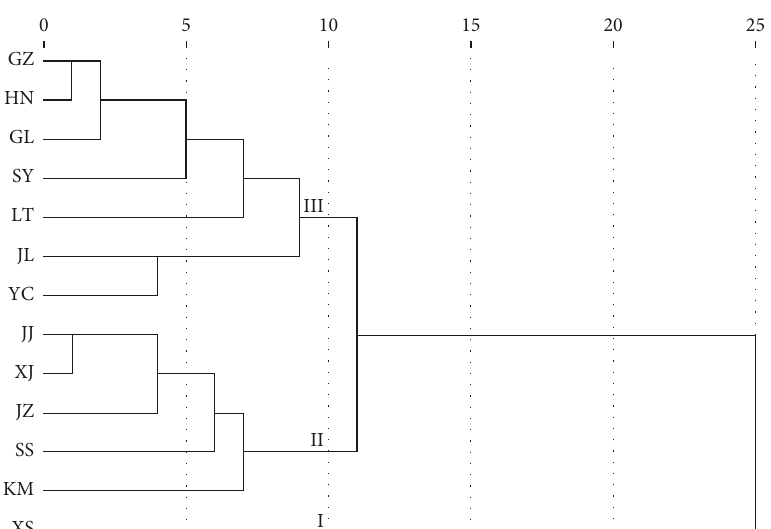
Figure 4: Hierarchical clustering analysis, based on nutrients and bioactive components, of the 13 Lycium chinense populations in China (see Figure 1 for population